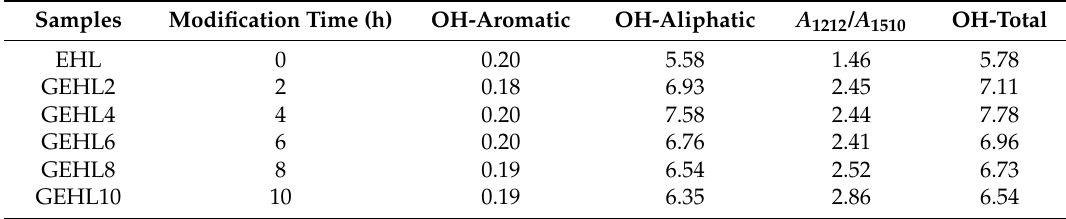
Table 2. Ratios of relative absorbance for different functional groups.